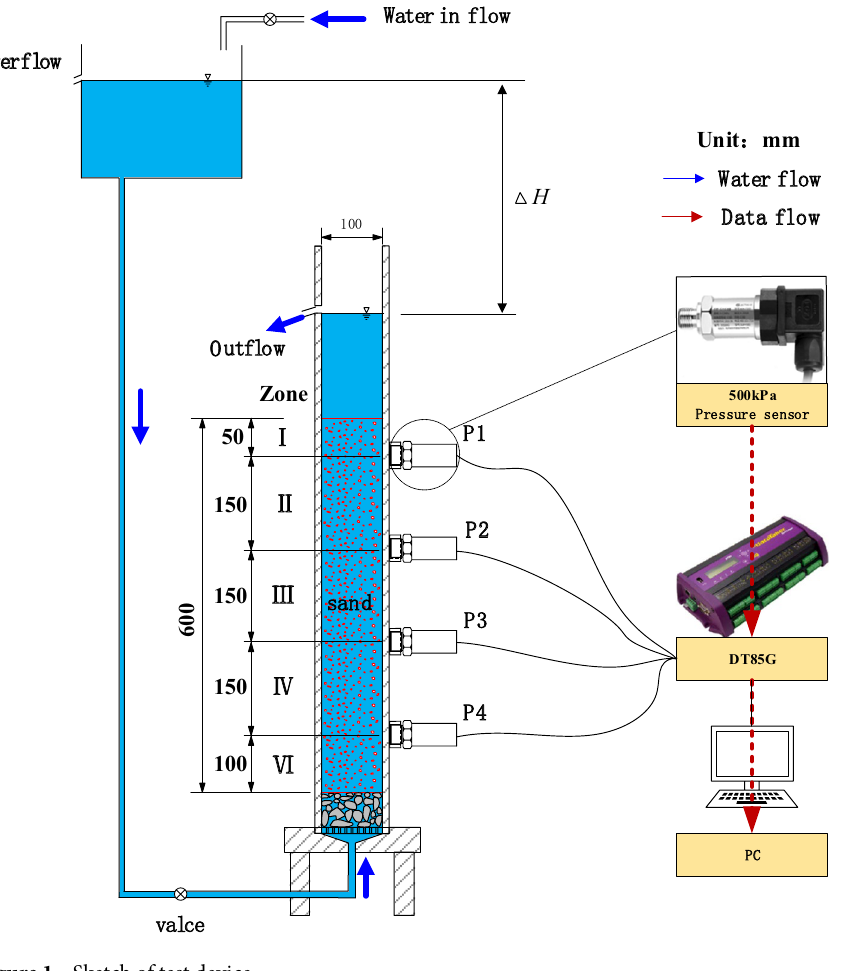
Figure 1. Sketch of test